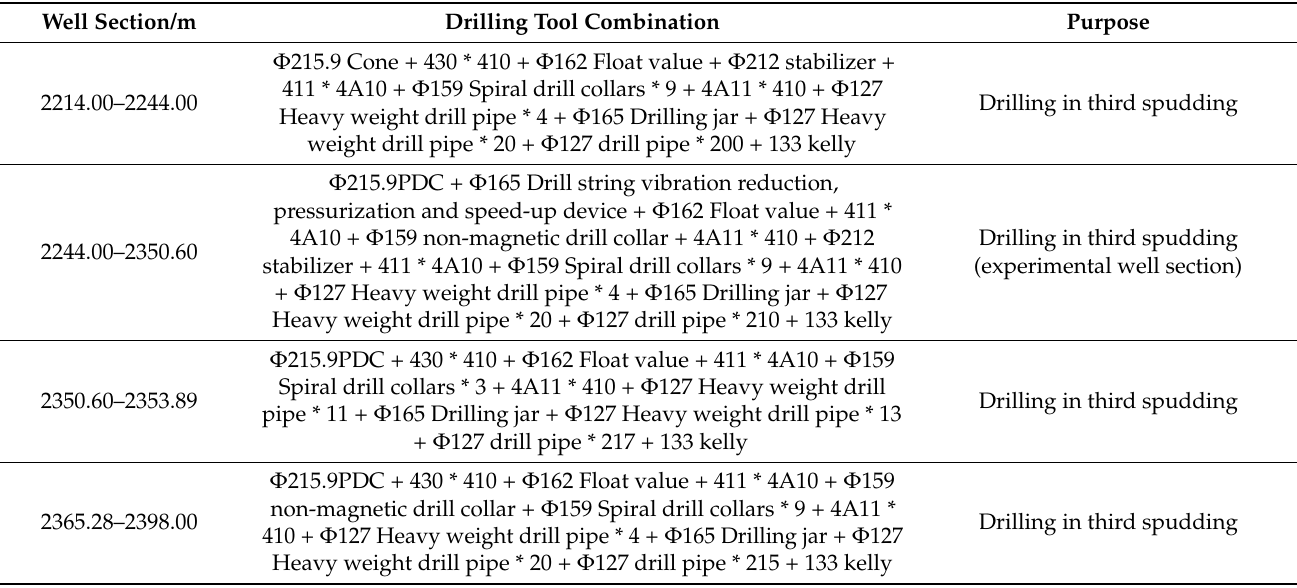
Figure 5. Photos of exit bit. Table 3. Situation of drilling assembly in wellbore of Φ 215.9 mm of WWY1 in the third